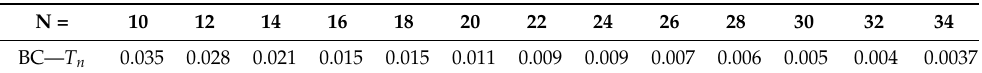
Table 3. The maximum norm for the difference between the boundary condition BC for temperature for l 1 = 1 and its